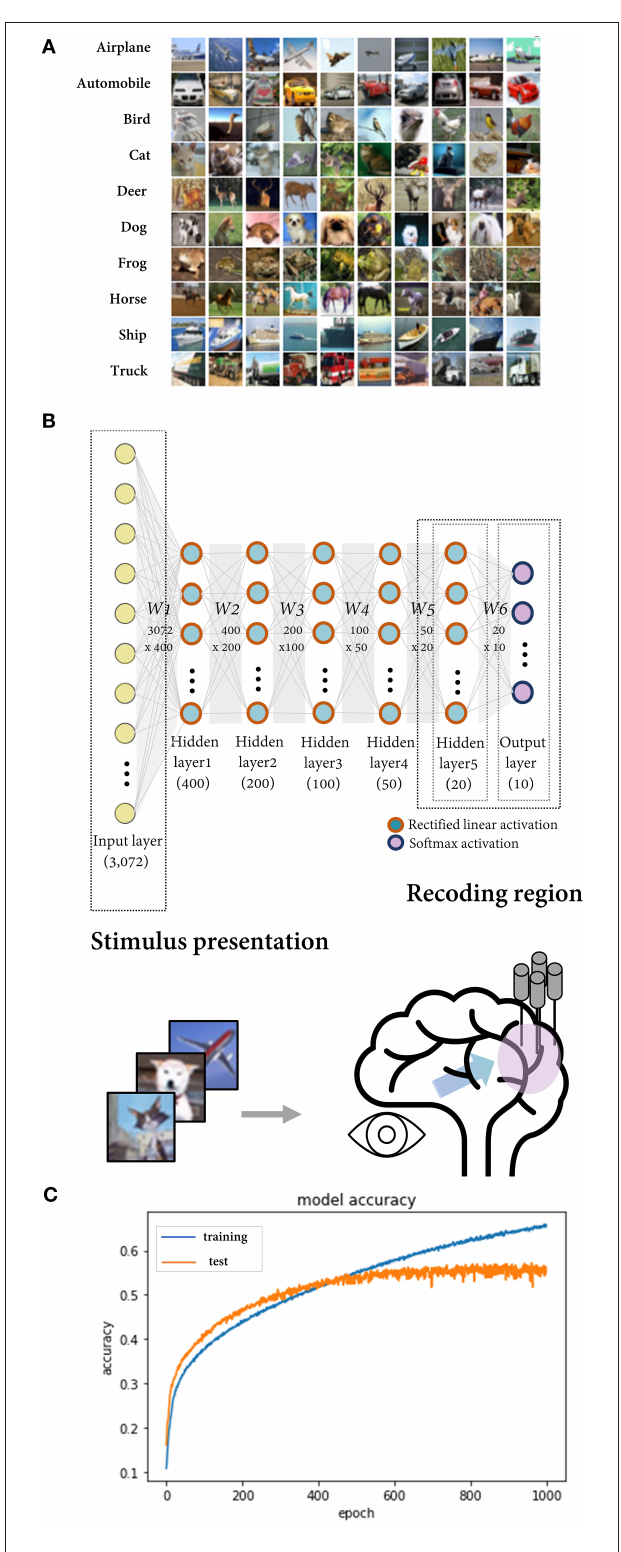
FIGURE 1 | The deep neural network trained on CIFAR-10 as a model of the biological neural network. (A) The CIFAR-10 dataset consisting of 32 × 32 × 3